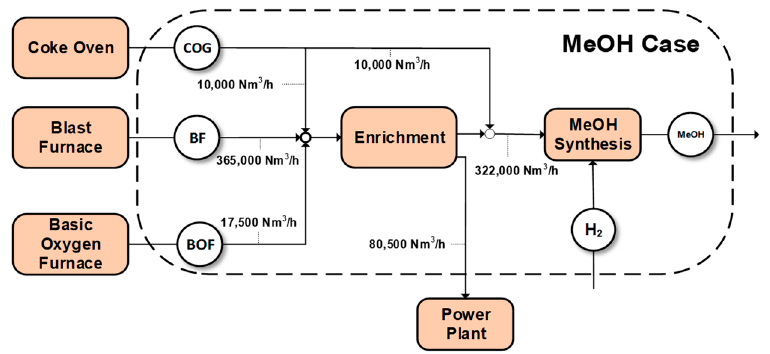
Figure 2. The NG case: replacement of natural gas demands of the steel plant.